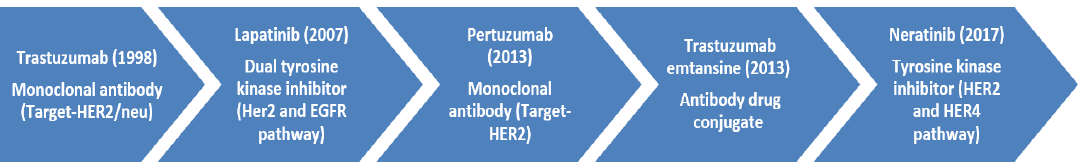
Figure 3. HER2-targeted therapeutic agents. Information in the chart includes the name of the drug, year of U.S. FDA approval, and type of receptor in order.